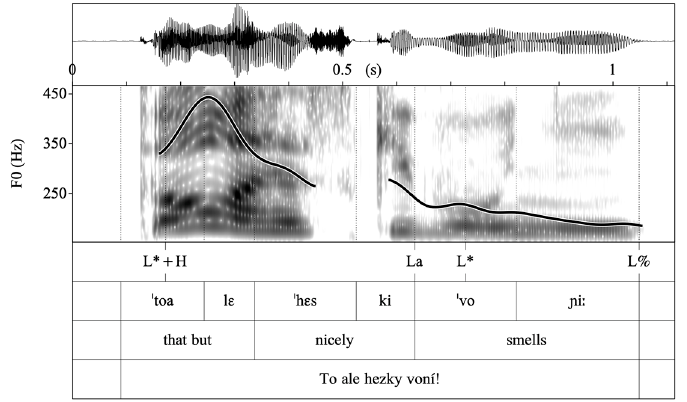
Figure 2. Waveform, spectrogram and F0 trace of the non-neutral statement of the obvious It is John Travolta! in L1 Czech produced with L*+H L%.